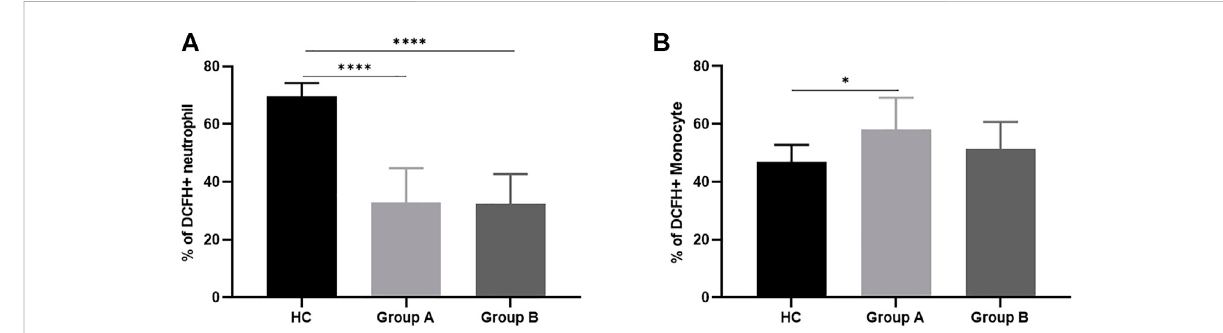
FIGURE 3 ROS production by neutrophils and monocytes in healthy controls and patients with abdominal sepsis of different age groups. Note: (A) Represents ROS of neutrophils. (B) Represents ROS of monocytes. Group A indicates the cohort of patients aged ≥ 65 years. Group A indicates the cohort of patients aged < 65 years. Reactive Oxygen Species, ROS. We utilize how many of the asterisks indicate the magnitude of the p -value. “ * ” indicates p < 0.05. “ **** ” indicates p < 0.0001.